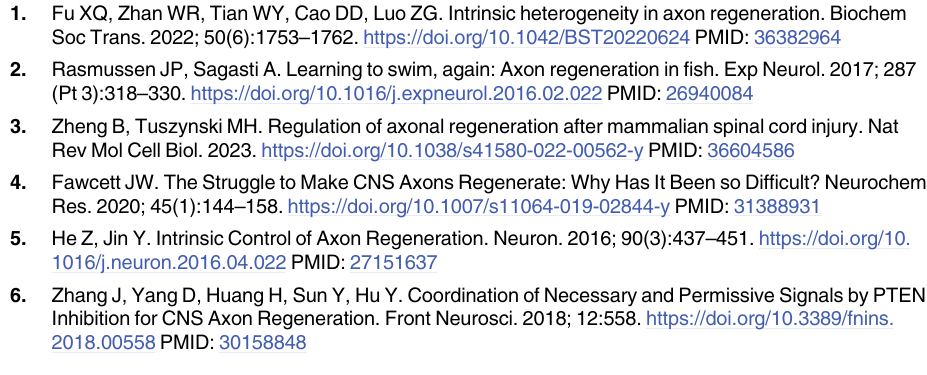
Fig 1. RSK family members drive enhanced protein synthesis in PNS neurons following axonal damage. In contrast AU : AbbreviationlisthasbeencompiledforthoseusedinFig 1 : Pleaseverifythatallentriesarecorrect : to the CNS, axonal injury in the PNS leads to an up-regulation and activation of RSK family members RSK1 and RSK2. Activation of RSK1 leads to phosphorylation of the known mTOR target eEF2K, allowing for the dephosphorylation and derepression of eEF2. This results in increased translation of pro-regenerative proteins such as BDNF. Similarly, activation of RSK2 leads to phosphorylation of the know mTOR target RPS6 at positions 235/236, again driving increased translation. Both of these activation pathways are independent of mTOR. It remains to be determined how these 2 pathways may synergize to drive the intrinsic growth capacity of PNS neurons. Since activation of RSK1 alone in retinal ganglion CNS neurons is not sufficient to drive axonal growth while activation of RSK2 is sufficient promote CNS regeneration in dorsal column neurons the extent to which RSK family members may be able to enhance CNS regeneration is still unclear. Created with BioRender.com. BDNF, Brain Derived Neurotrophic Factor; CNS, central nervous system; eFEF2, eukaryotic elongation factor 2; mTOR, mammalian target of rapamycin; PNS, peripheral nervous system; RPS6, ribosomal protein S6; RSK, p90 ribosomal S6